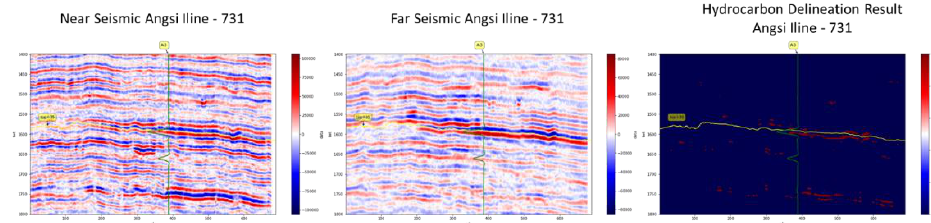
Figure 13. Hydrocarbon delineation result on “X” Seismic Inline—731 using SOM.